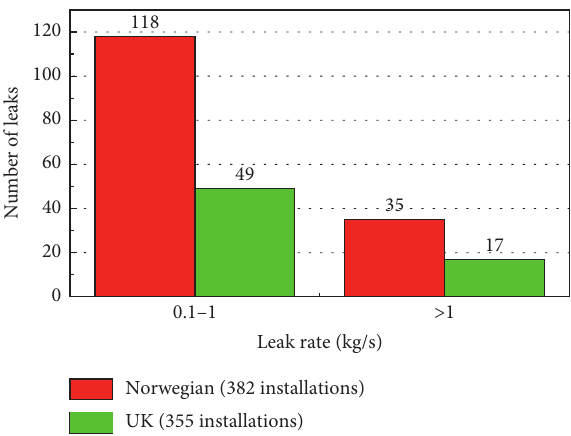
Figure 7: Leak rate data from installations in the North Sea.